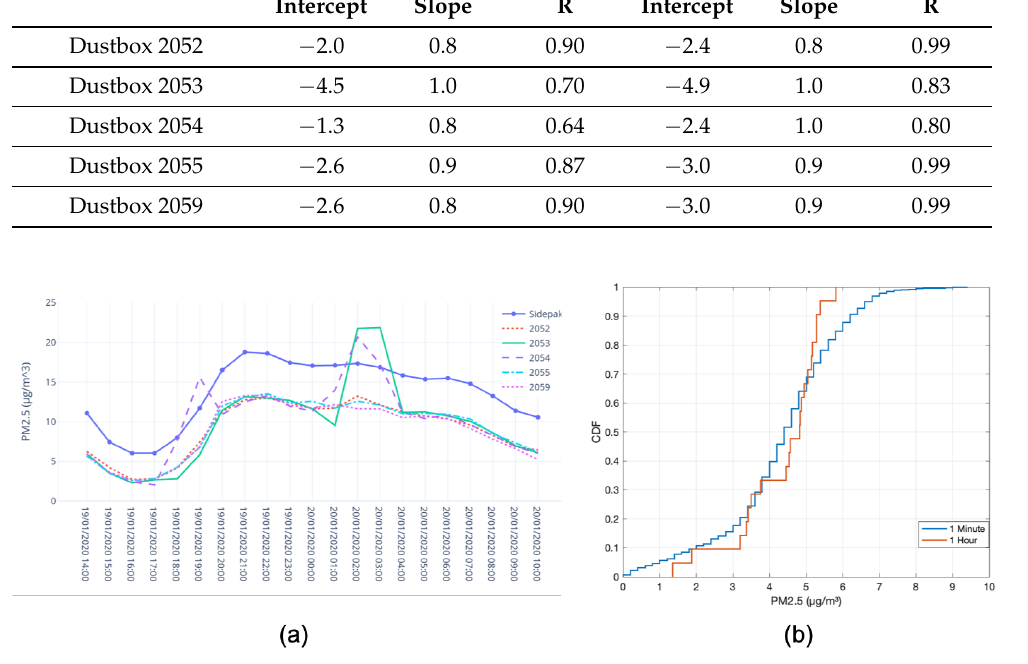
Figure 11. Performance comparison of Dustox2.0 and TSI AM520 for indoor colocation: ( a ) line plot for hly data; and ( b ) CDF plot to understand the difference between the values recorded by Dustboxes and TSI AM520